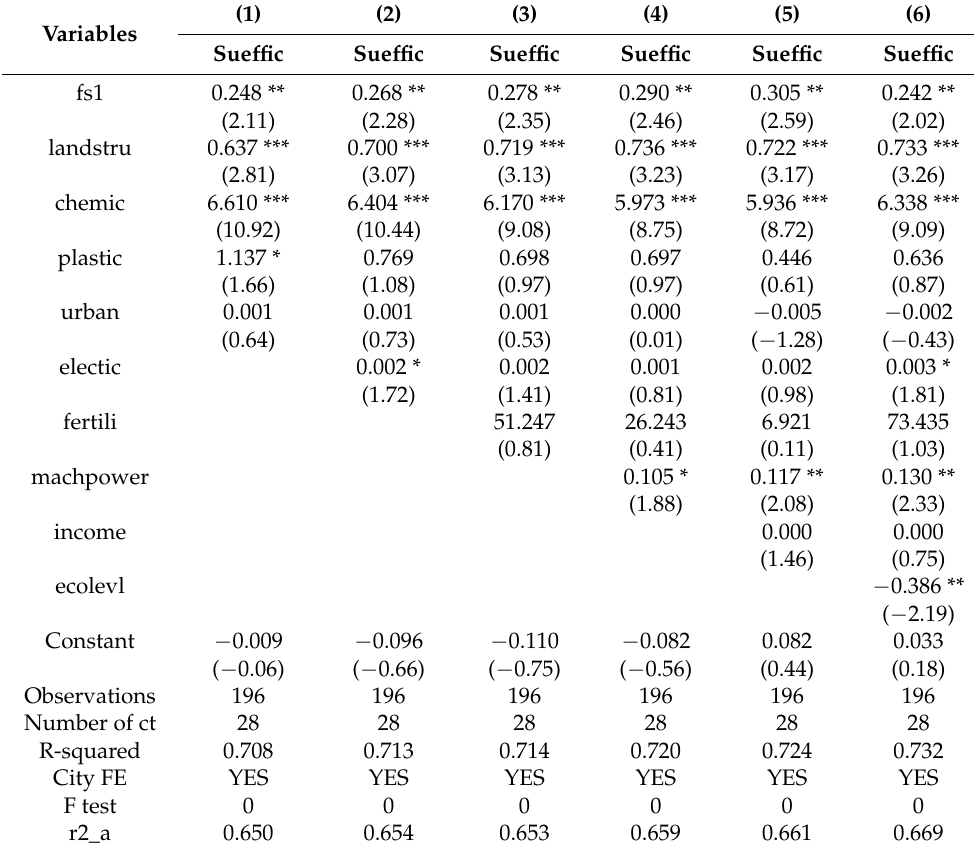
Table 8. Results of the individual fixed-effect regression.